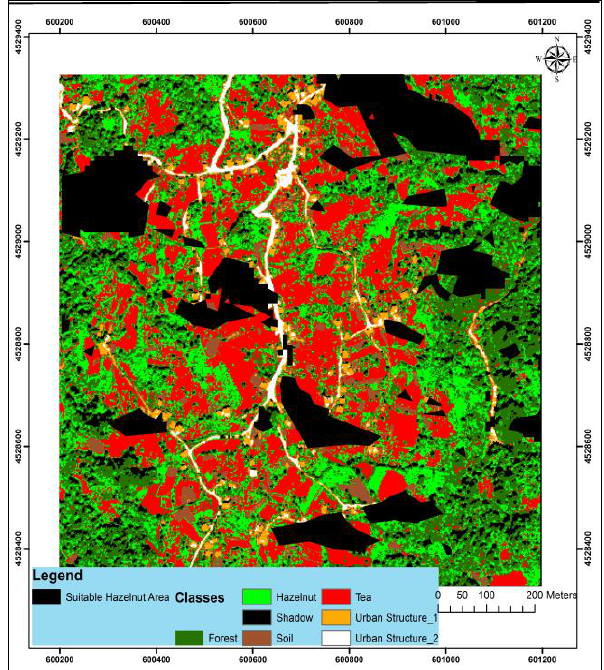
Figure 3. Suitable Hazelnut